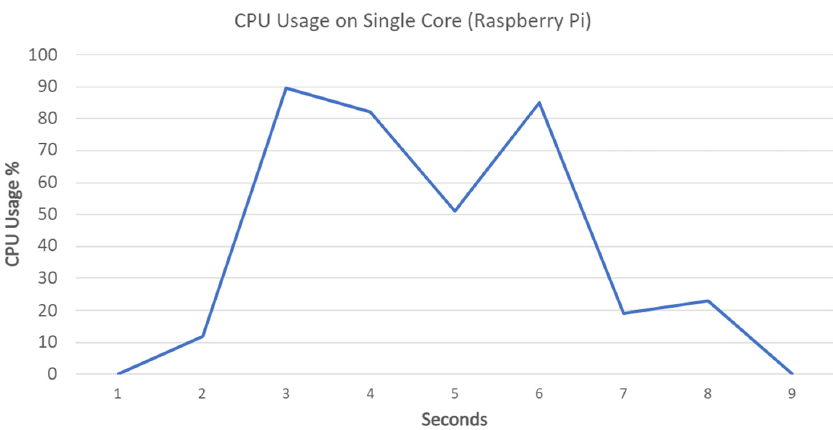
Figure 30. CPU usage on a single core (Raspberry Pi).